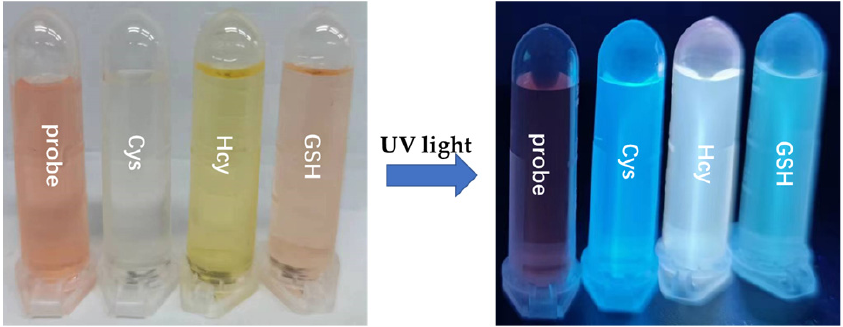
Figure 1. The photos of SWJT-14 with Cys, Hcy and GSH in visible light and UV light at 365